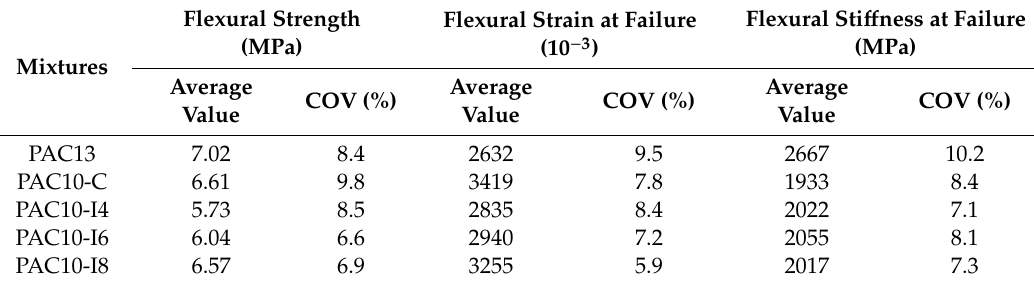
Table 7. Low-temperature bending test